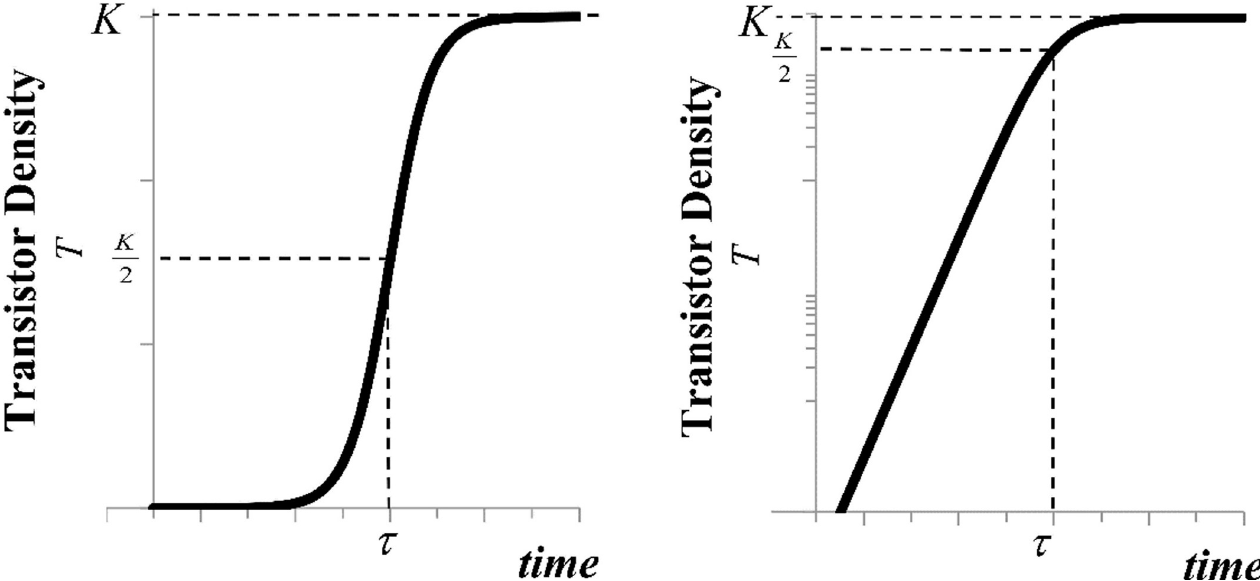
Fig 1. The general shape of the time-dependent logistic model compared with the curve following semilog transformation. A) The logistic model on a linear scale. B) The semilog transformation of the logistic model. Note the nearly exponential behavior of the initial phase of the function. The midpoint half- saturation point ( τ ) and asymptotic saturation ( K ) are